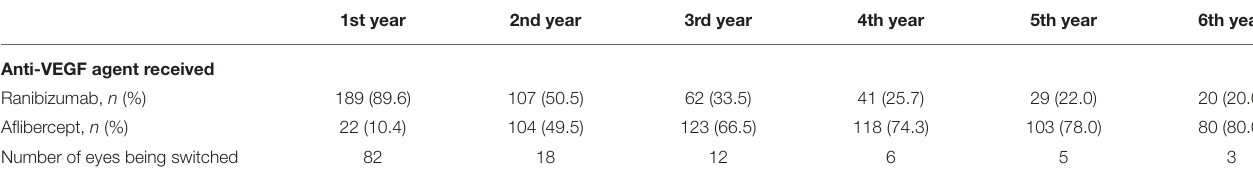
TABLE 2 | Distribution of anti-VEGF agents.